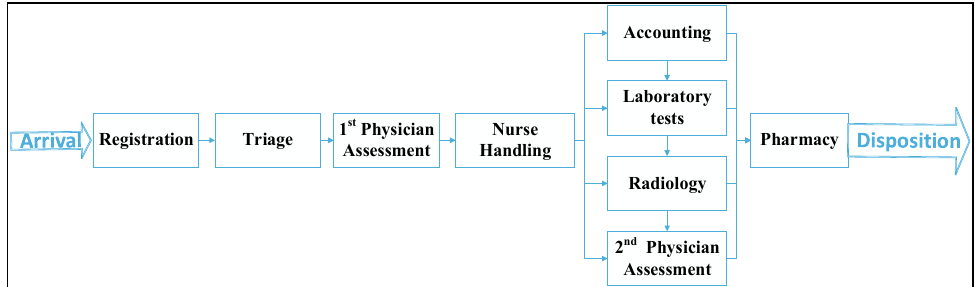
Figure 4. General process flow chart.